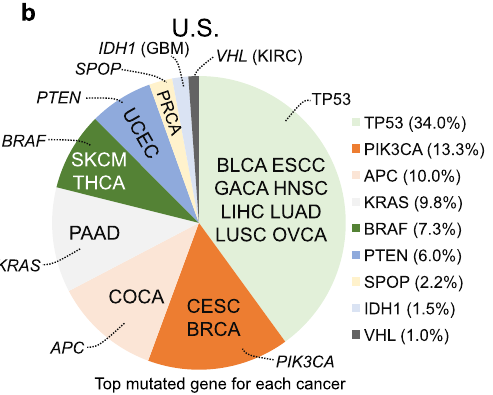
Fig.3|TopmutatedgenesinCNandU.S.cancers.a,b Thetopmutatedgenesfor each of the 18 cancer types in the China and U.S pan-cancer cohorts. The case numberforeachcohortareBLCA(CN_163vsU.S._411),BRCA(CN_303vsU.S._1020), CESC (CN_76 vs U.S._289), COCA (CN_1541 vs U.S._545), ESCC (CN_914 vs U.S._95), GACA (CN_973 vs U.S._439),GBM (CN_286vs U.S._896), HNSC(CN_94 vs U.S._508), KIRC(CN_243vsU.S._361),LIHC(CN_1131vsU.S._364),LUAD(CN_1370vsU.S._1027), LUSC(CN_392 vs U.S._485), OVCA (CN_185 vs U.S._426), PAAD (CN_461 vs U.S._177), PRCA (CN_65 vs U.S._497), PTC (CN_71 vs U.S._346), SKCM (CN_27 vs U.S._366),and UCEC (CN_49 vs U.S._531). Cancer type abbreviations: Esophageal squamous cell